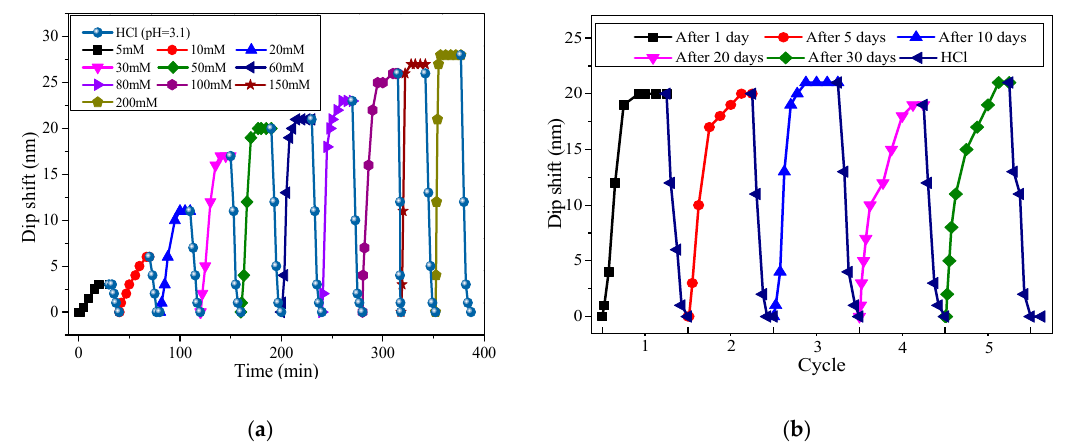
Figure 11. Repetitive experiment of the SPR Hg 2+ sensor in different Hg 2+ concentrations ( a ) and the same Hg 2+ concentration ( b ).